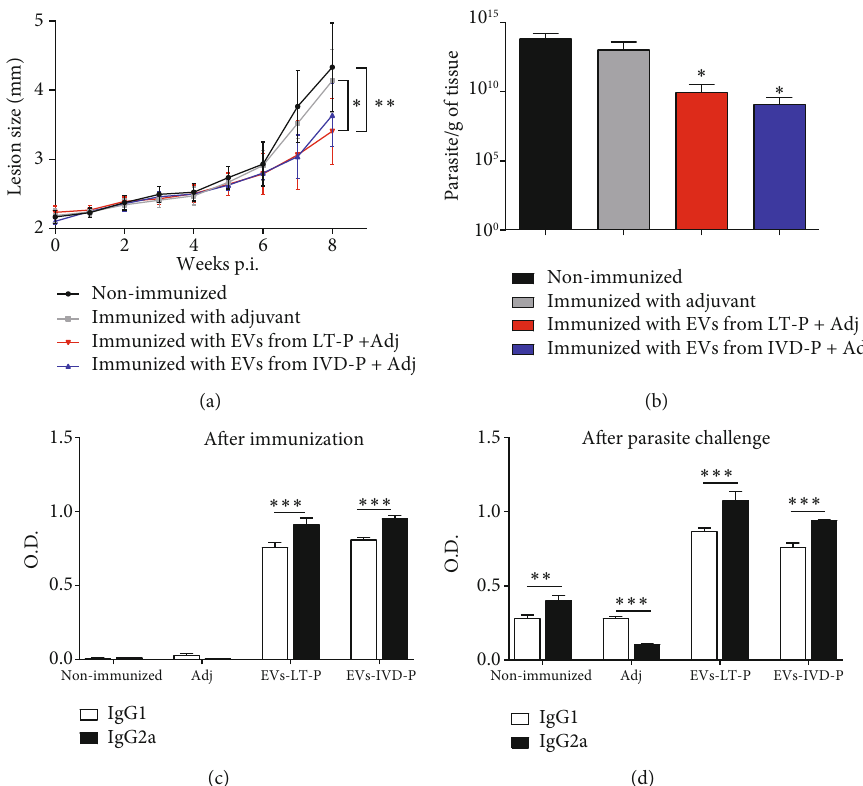
Figure 6: BALB/c mice were managed with the two-dose protocol. (a) Footpad size (millimeter (mm)) measurements ( n = 7 ). Each point represents the average of the measurements. ANOVA followed by a post hoc Tukey ’ s test; ∗ P < 0 : 05 : adj compared with mice immunized with LT-P; ∗∗ P < 0 : 01 : nonimmunized infected mice compared with the group immunized with LT-P. (b) Parasite load ( n = 7 ). Bars denote the average of measurements, and error bars denote the SD. Kruskal-Wallis test followed by Dunn ’ s test; ∗ P < 0 : 05 compared with the nonimmunized group. (c) Production of IgG1 and IgG2a isotype antibody anti-EVs after 2 doses of EV immunizations. (d) Measurement of the IgG1 and IgG2a isotype antitotal extract of L. amazonensis in mice immunized and challenged with the parasite. Bars represent the average of 7 measurements, and error bars show the SD. Two-way ANOVA followed by post hoc Sidak ’ s test ð ∗∗ P <0 : 01 and ∗∗∗ P < 0 : 001IgG1versus IgG2ain eachgroup Þ . Nonimmunized: nonimmunized infected mice; Adj: mice immunized with adjuvant; EVs-LT-P: mice immunized with EVs released by LTP-P; EVs-IVD-P: group of mice immunized with EVs from IVD-P. Data are representative of 3 independent